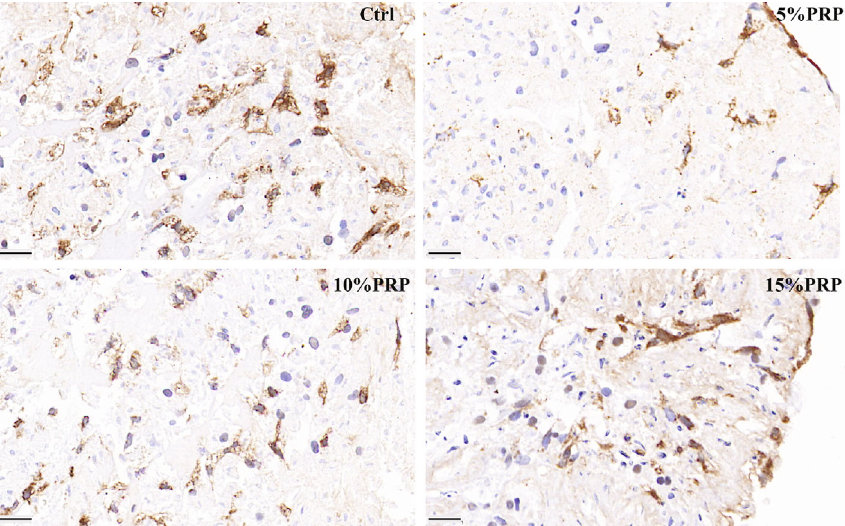
Figure 7: Type II collagen immunohistochemistry of BMSC pellets after 3-week culture in vitro in commercial chondrogenic medium (Ctrl) and 3 PRP groups. Positive staining is indicated by a reddish brown color. Scale bar = 20 μ m